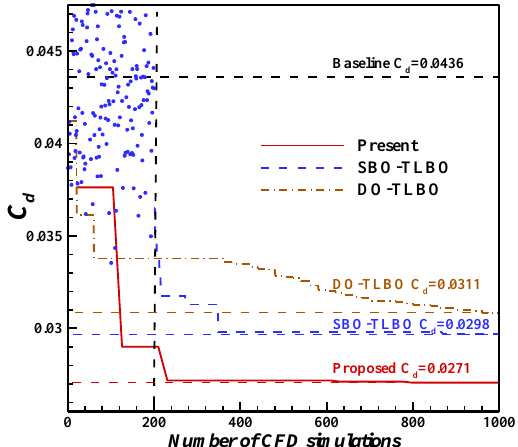
Figure 10. Convergence process drag coefficient ( C d ) by proposed, SBO, and DO methods.